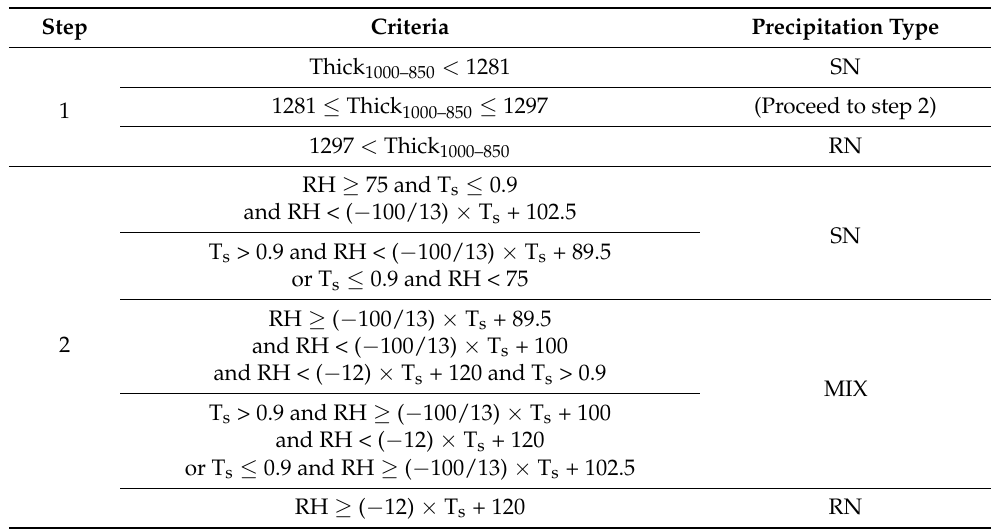
Table A1. Criteria of the optimized Matsuo scheme to determine the precipitation type. Adapted from [15] with permission from Korean Meteorological